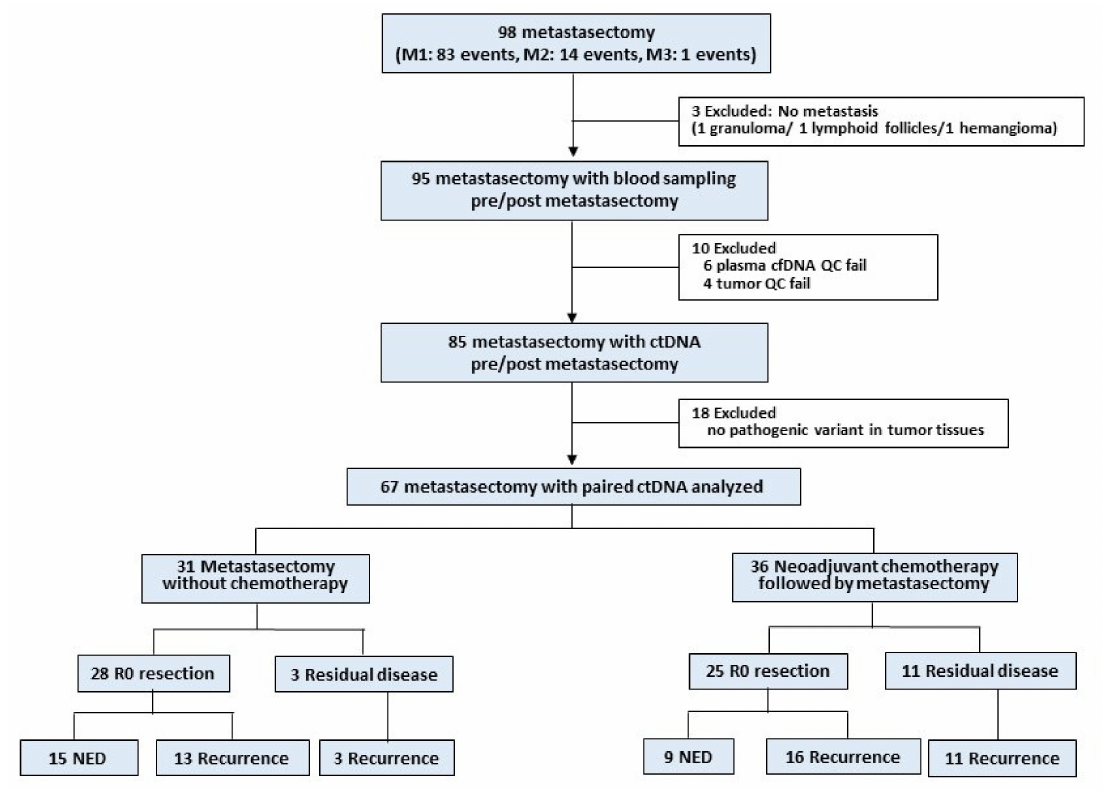
Figure 1. Workflow of the exploratory prospective study.